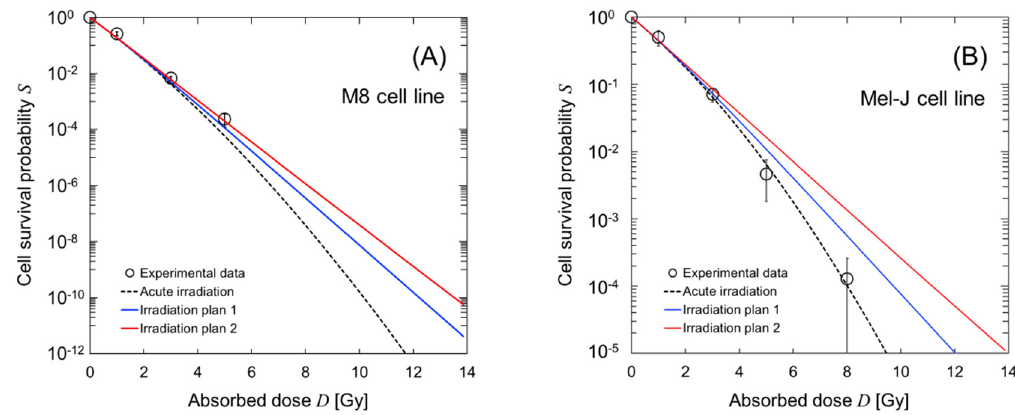
Figure 7. Estimation of the dose–response curve for cell survival considering the 10 B concentration dynamics during BNCT irradiation. To estimate the curves, we used the model parameters for the M8 and Mel-J cell lines (Table 1) and the irradiation regimens described in Figure 6. ( A , B ) shows the curves for the M8 and Mel-J cell lines, respectively. The symbols are the experimental data measured using high-dose-rate neutrons at 1.0 Gy / min [39].